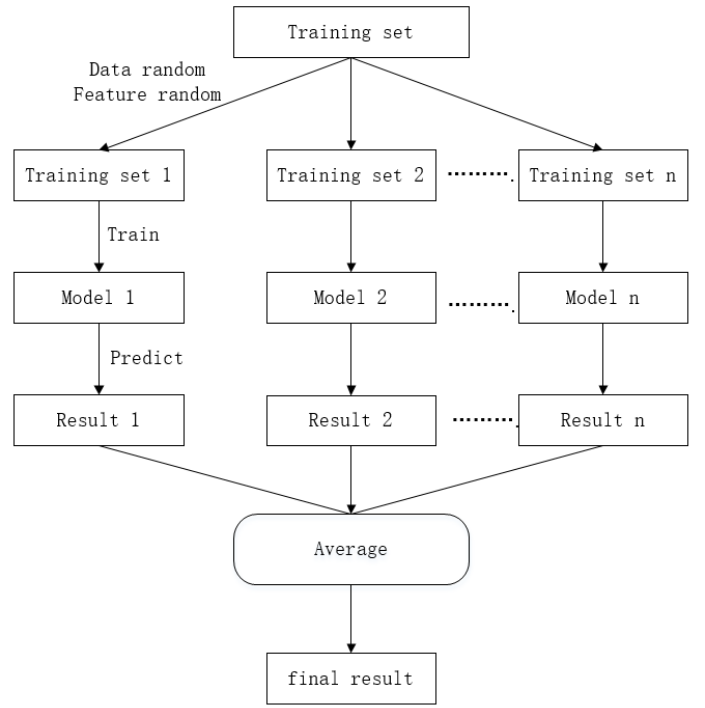
Fig. 14 RF model process. RF, Random